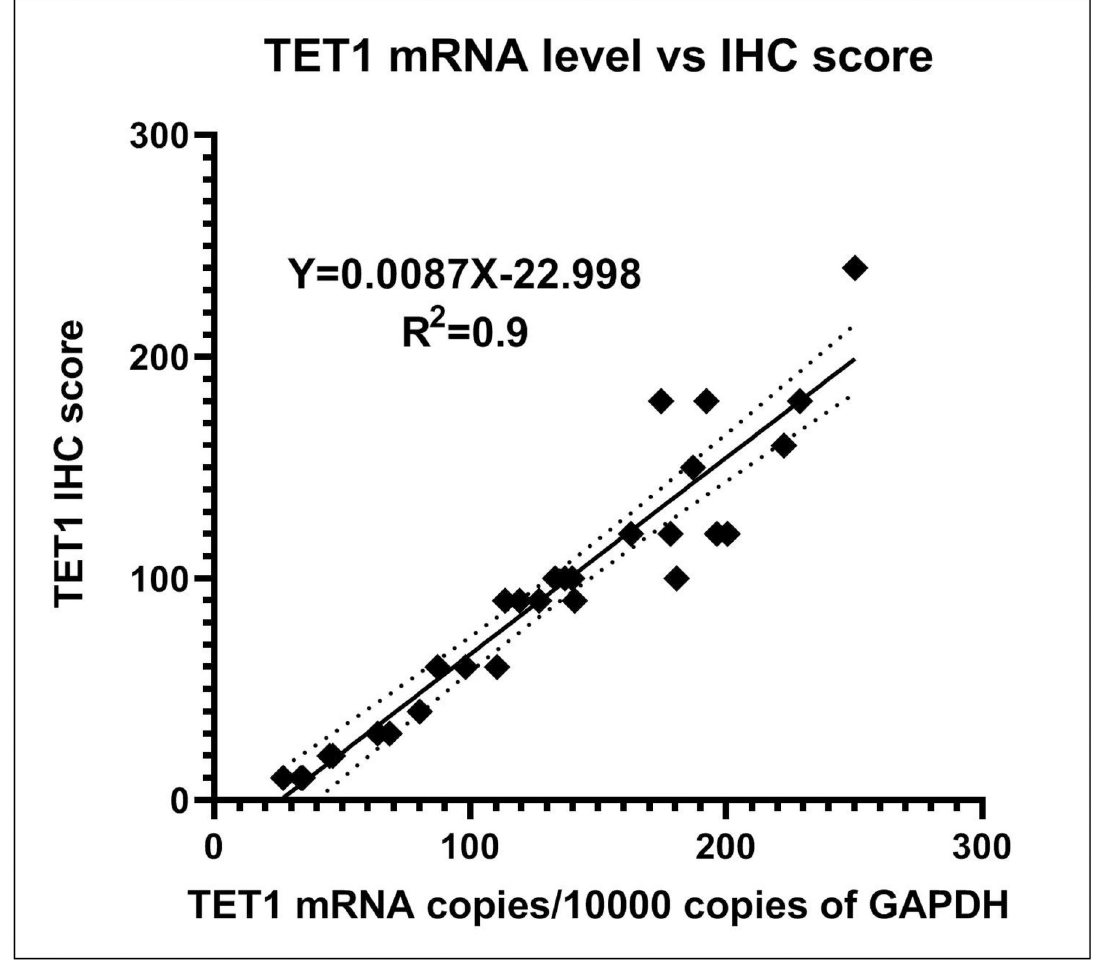
Fig 3. Comparison of TET1 IHC score and TET1 mRNA level. The two parameters were compared and analyzed by simple linear regression. The TET1 mRNA copies were calculated and shown with every 10,000 copies of GAPDH. The dotted line means the 95% confidence interval of simple linear regression